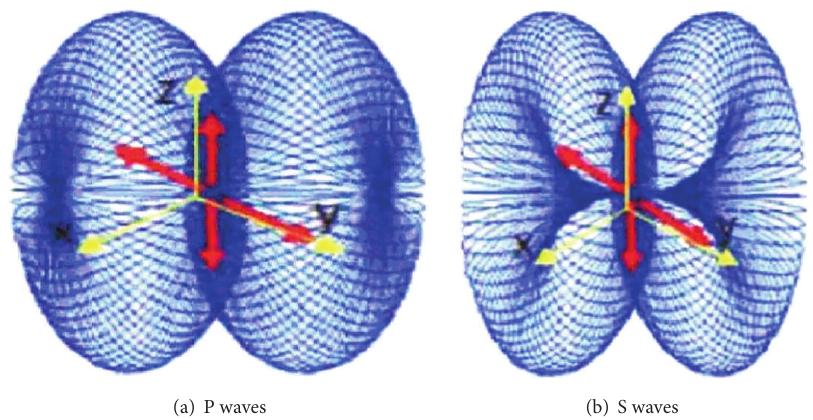
Figure 4: Diagrams of waves propagation from combination of two double forces.